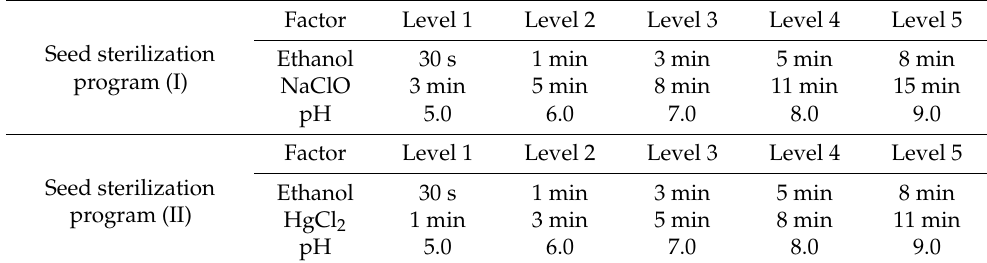
Table 1. Sterilization programs and parameters of Suaeda aralocaspica